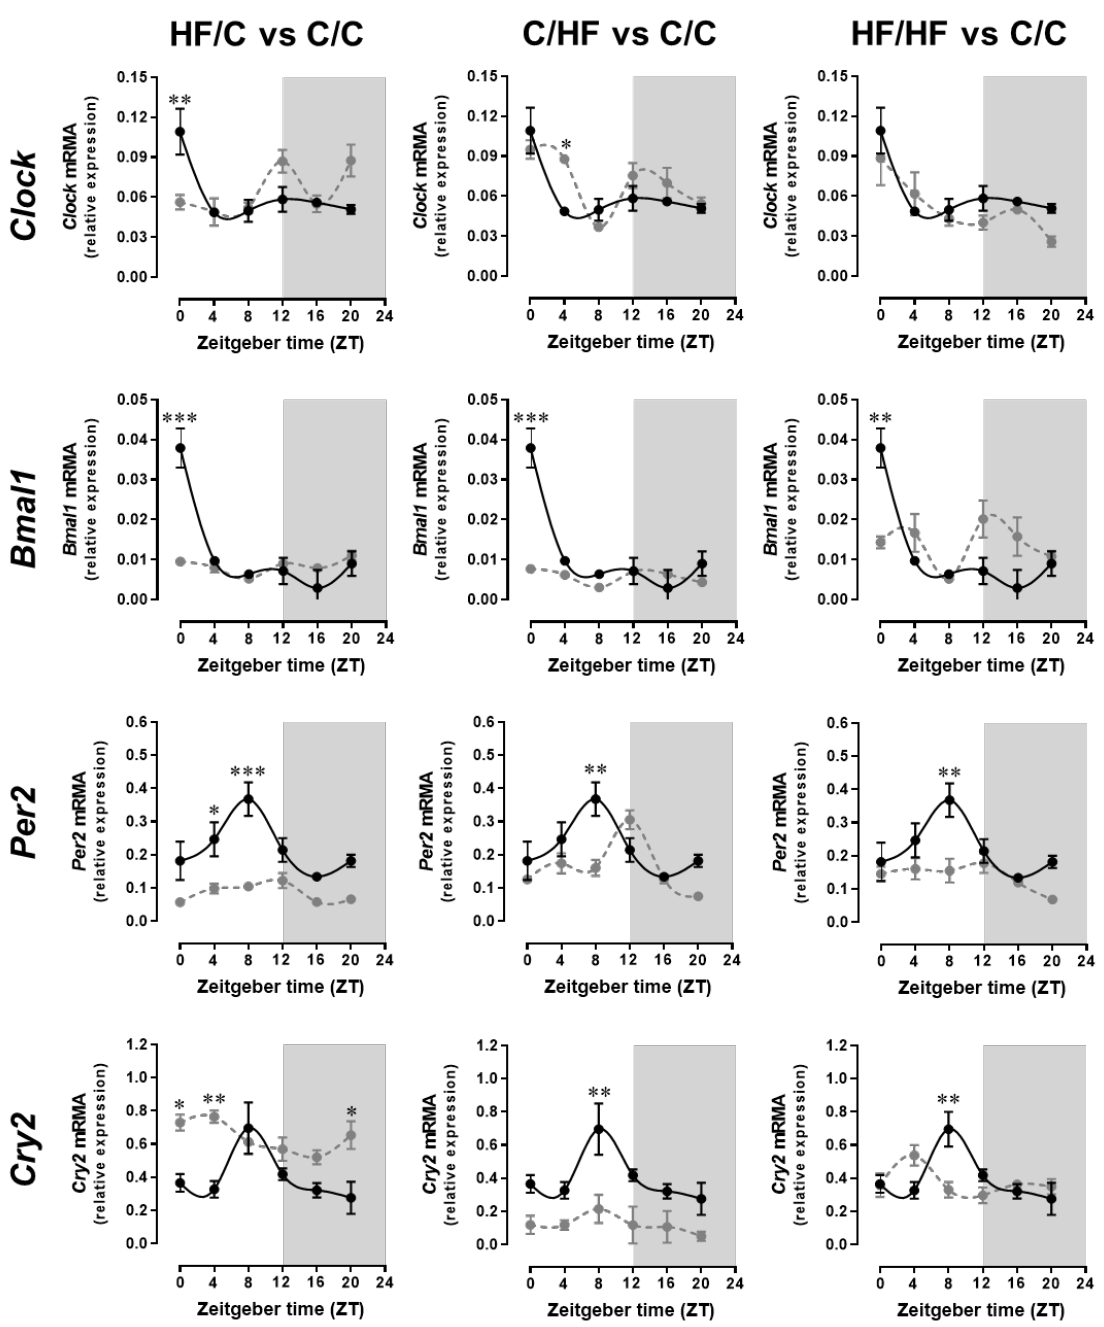
Figure 2. Maternal obesity and postweaning HF diet consumption disrupts circadian rhythms of clock gene expression in the suprachiasmatic nucleus (SCN). Transcripts of the core clock genes Clock , Bmal1 , Per2 , and Cry2 in the SCN were analysed by real-time PCR. Tissues were harvested every 4 h from 15-week-old male offspring from lean dams and on the control diet (C/C offspring, black lines), control-fed offspring from obese dams (HF/C offspring, grey lines), or with the HF-fed offspring from lean (C/HF group) or obese (HF/HF group) dams (grey lines). Values are displayed as relative expression (mean ± SEM) after normalisation to the housekeeping genes β -actin and Gapdh . ANOVA with Tukey post hoc test. * p < 0.05, ** p < 0.01, *** p < 0.001 between groups at each time point.